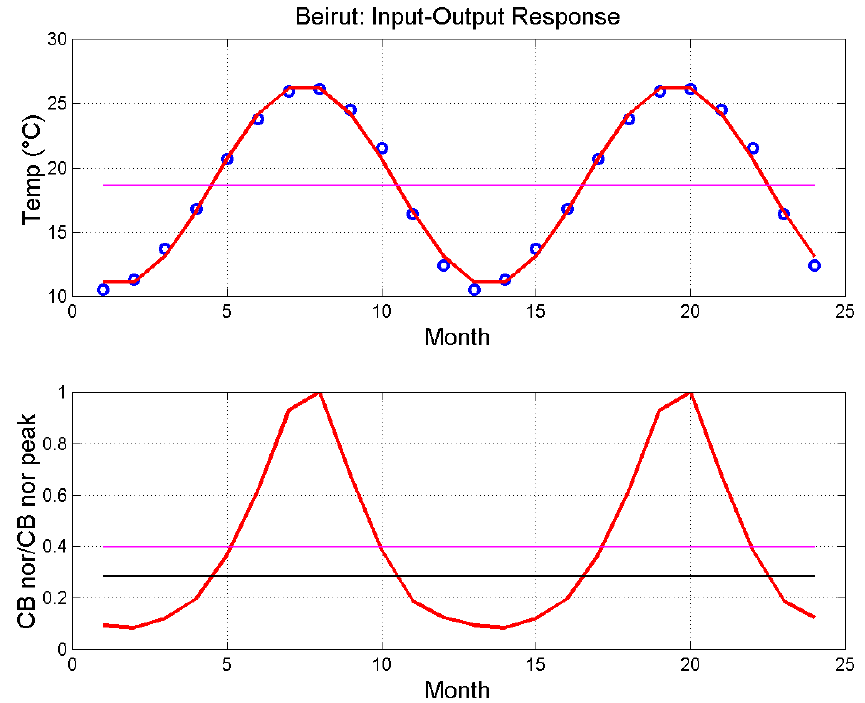
Figure 3. Upper panel: Monthly average temperature measured in Beirut [30] (blue dots) and modelled by Equation (5) (red curve); the magenta line reports the annual average temperature. Lower panel: CB nor output divided by its maximum value (red curve) according to Equation (5), for N = 1 year. The magenta line reports the average value of the red curve; the black line draws the output CB nor divided by the maximum value of the red curve when the input to Equation (5) is the annual average temperature reported in the upper panel. In both panels, two annual cycles are drawn to show continuity between December and January.